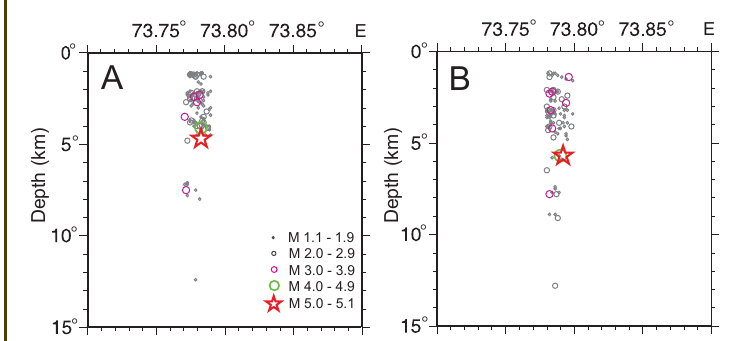
Figure 2. Depth sections of the two blocks shown in Fig. 1 in pink. Number of earthquakes during 2009–2010 in [A]: M1.1–1.9 (81 events), M2–2.9 (26 events), M3–3.9 (5 events), and one earthquake each of M4.3 and M5.0. In [B], M1.1–1.9 (54 events), M2–2.9 (24 events), M3–3.9 (7 events), and one earthquake each of M4.2 and M5.1.